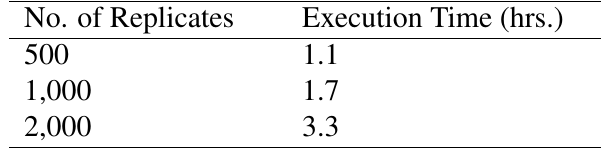
Table 5: The execution times of the integrated tree inferring workflow for DNA using our own deployed local and helper